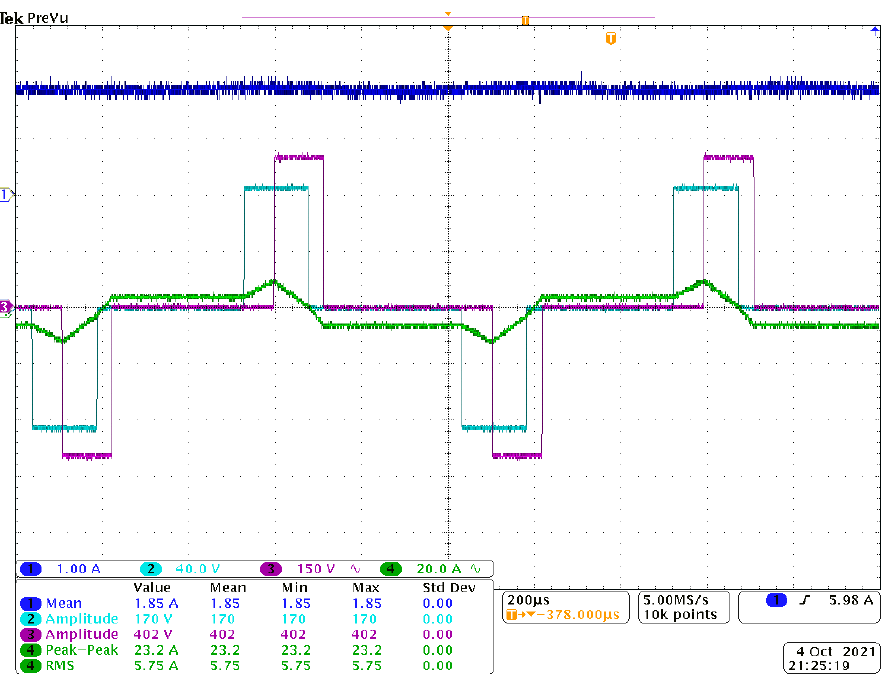
Figure 20. DAB operation under the TPS method at low